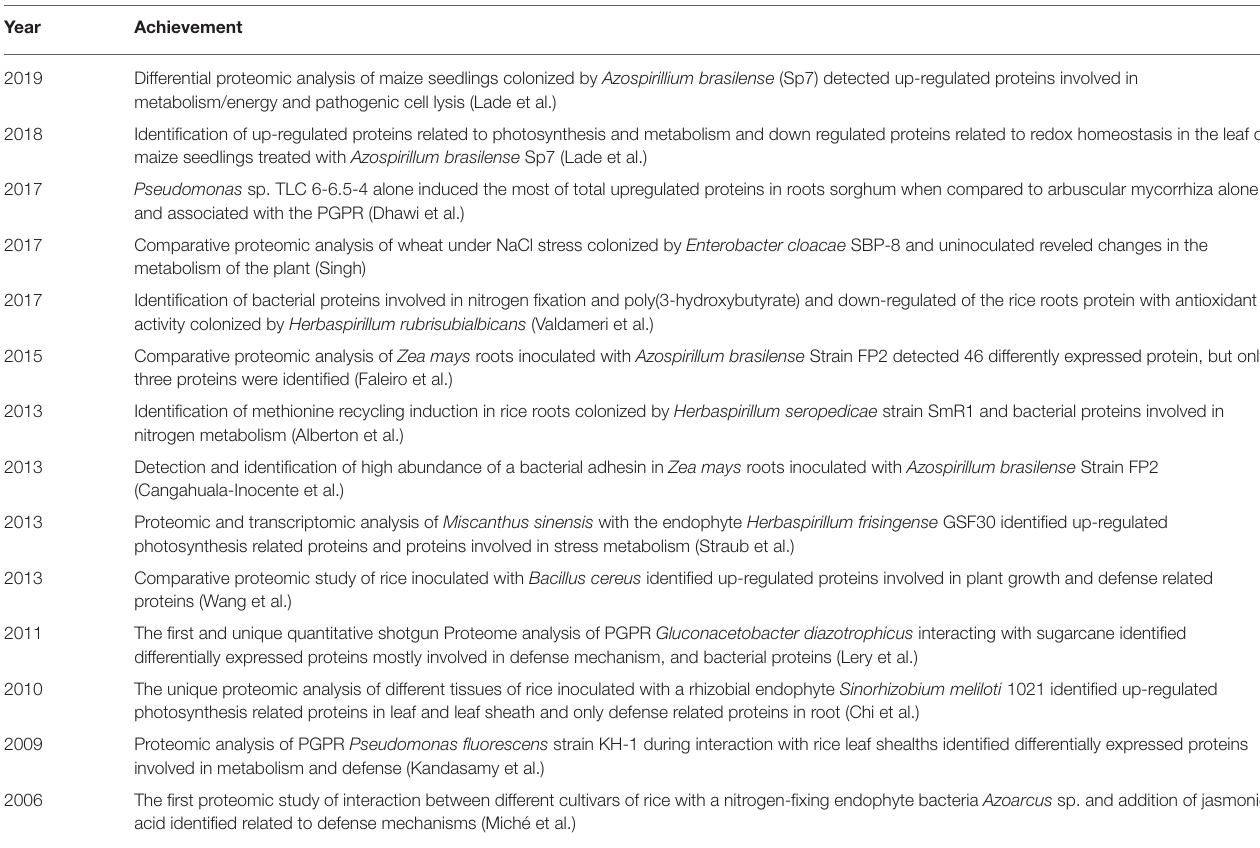
TABLE 1 | Progress in grass-bacteria interactions based on proteomics